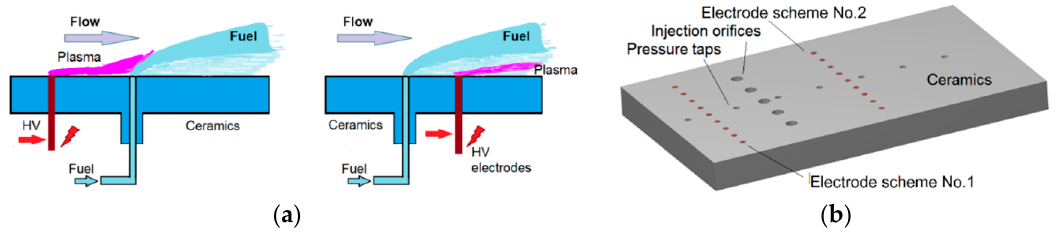
Figure 8. ( a ) Schematic drawing of two basic layouts for the fuel injectors and electrode arrangement; ( b ) 3D view of ceramic insertion used during testing.